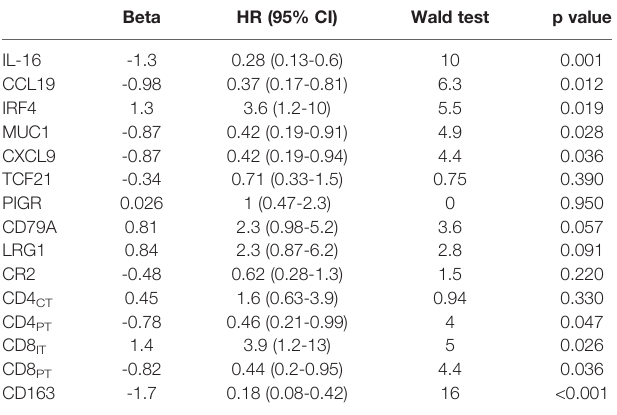
TABLE 2 | Univariate Cox regression analysis of prognostic factors in the training cohort.